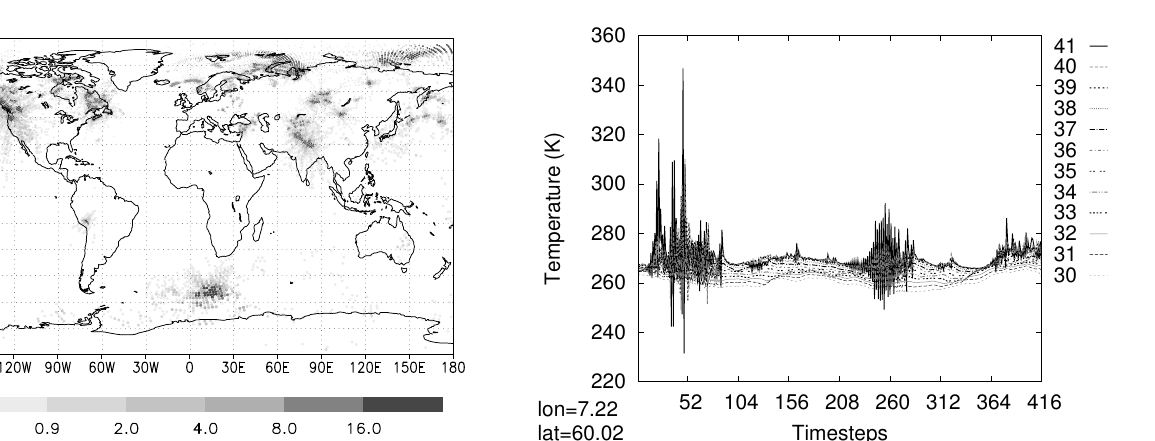
Fig. 8. The left figure shows the amplitude of 2∆ t temperature oscillations on the lowest model level (in Kelvin) after 96 hour forecast computed according to Equation 9 for the model run with the fibrillation amplification test of the large scale precipitation scheme but when the evaporation of precipitation is switched off. The figure on the right shows temperature (in Kelvin) in one model point on the 12 lowest model levels for each time-step during the 96 hour forecast for the model run with the fibrillation amplification test of the large scale precipitation scheme but when the evaporation of precipitation is switched off.